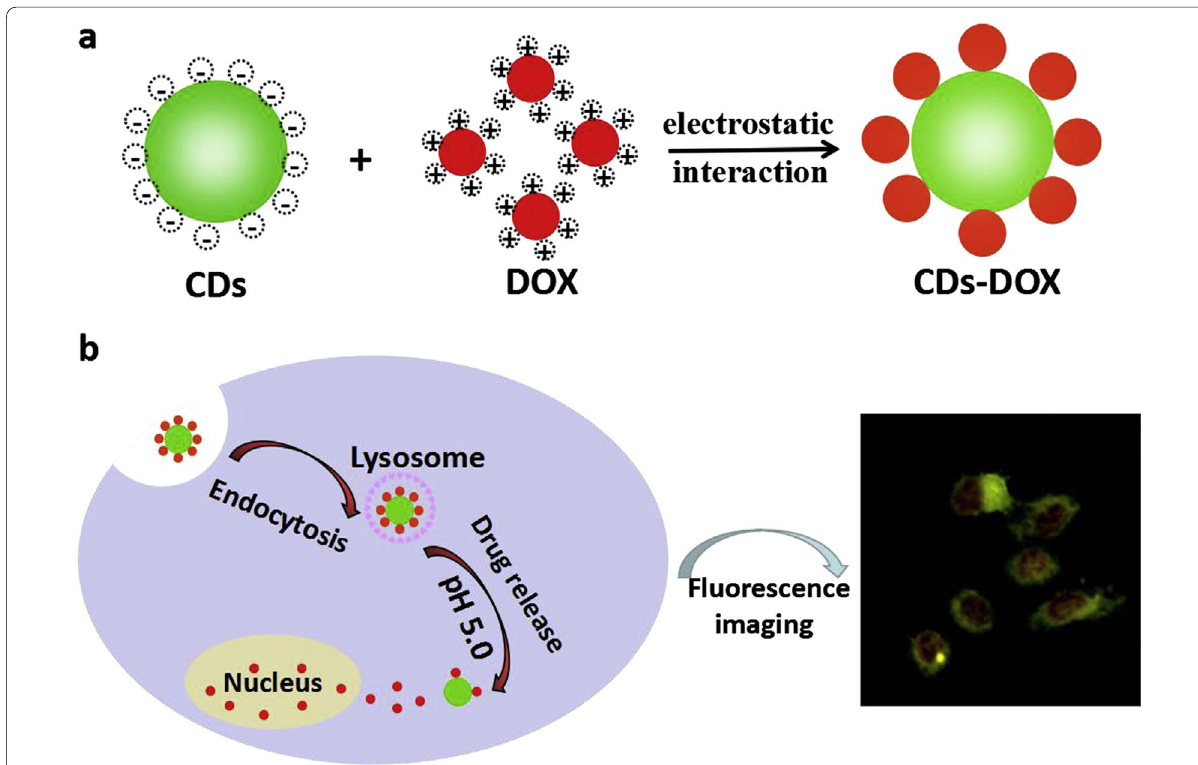
Fig. 7 Schematic illustration of the preparation ( a ) and cellular uptake ( b ) of the CDs-DOX drug delivery system [113]